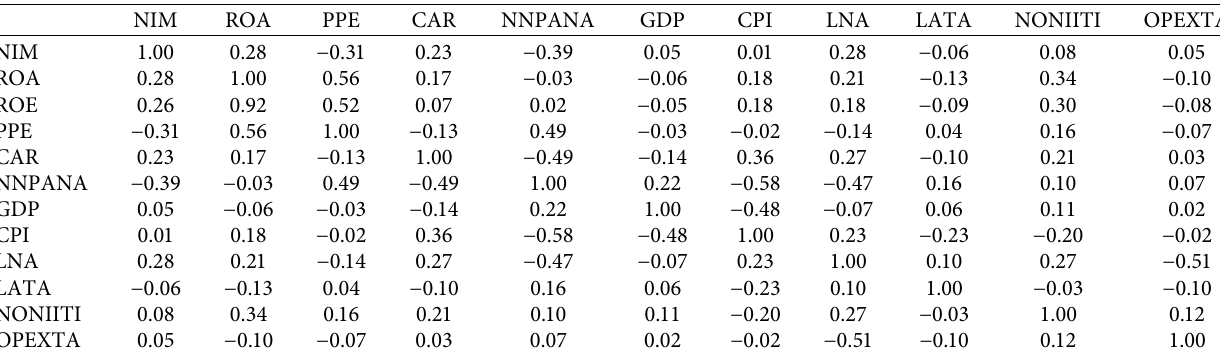
Table 4: Correlation matrix for the dependent and independent variables.